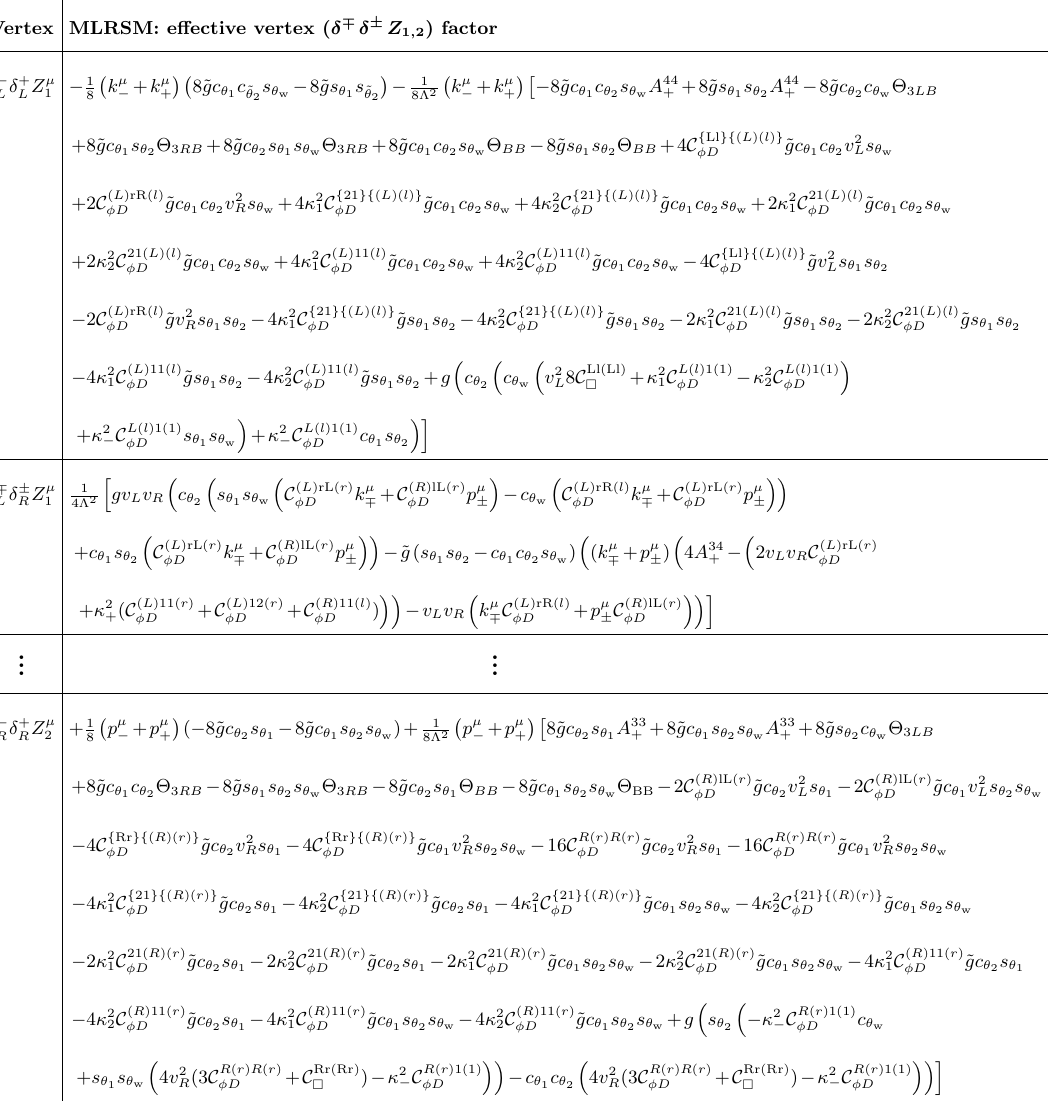
and (cid:14) (cid:6) . ~ (cid:18) 2 is the L R